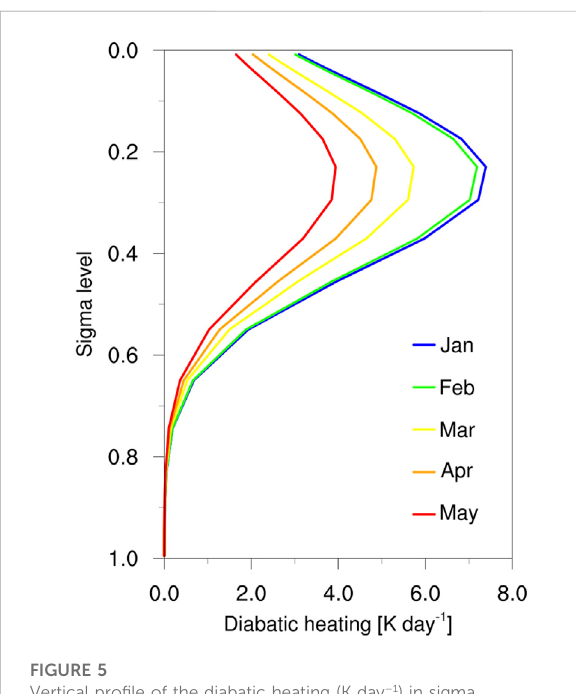
FIGURE 5 Vertical pro fi le of the diabatic heating (K day – 1 ) in sigma coordinates at the maximum location (160 ° W, 0 ° S). Considering the decaying ratio of the ENSO in Figure 2A, forcing with the intensity of 1, 0.97, 0.78, 0.66, and 0.53 times theJanuaryforcing are arbitrarily created from January to May. The heating in January to May are expressed by blue to red colors (explained in the legend).